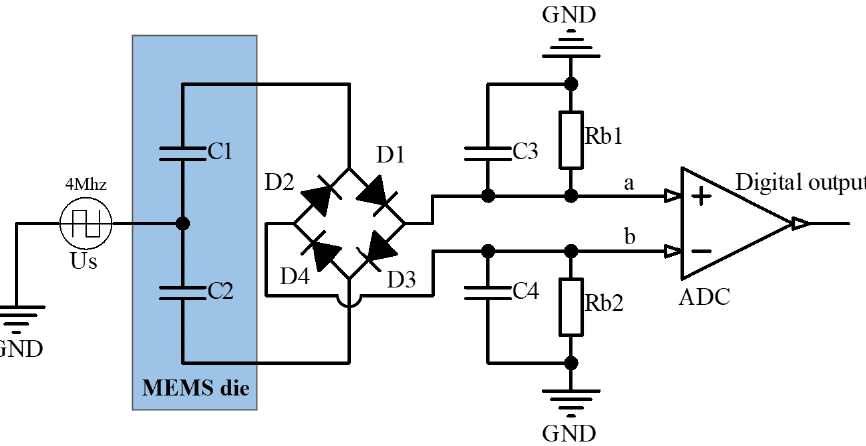
Figure 3. Schematic diagram of the capacitive open-loop accelerometer based on ring-diode capacitance detection.